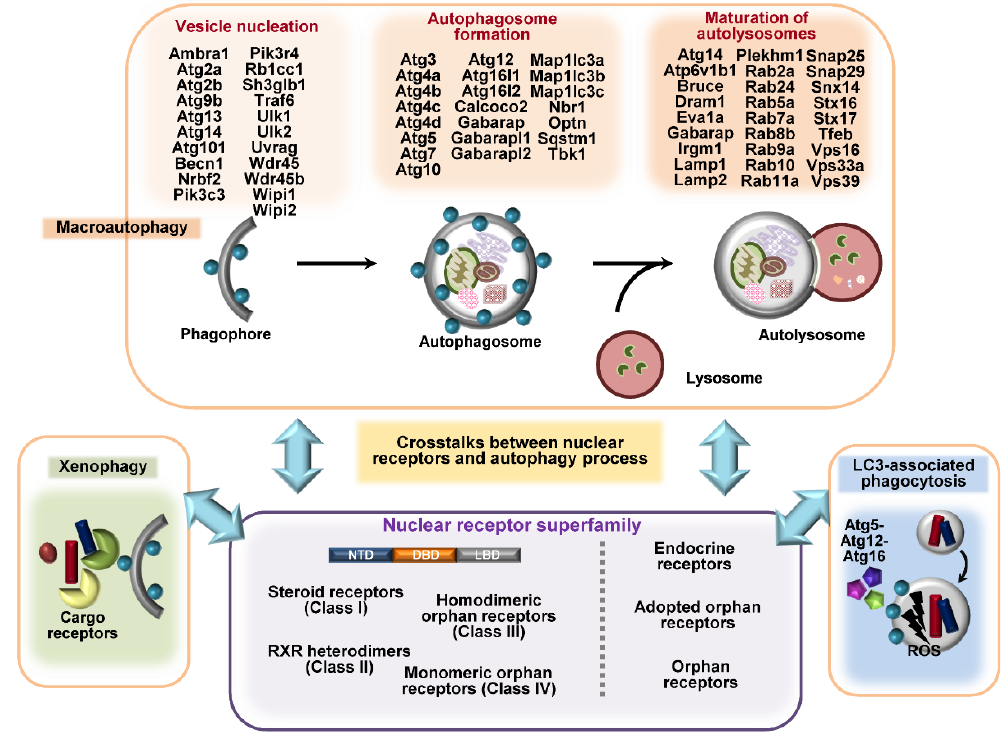
Figure 1. A summarized figure for autophagy genes and different classes of nuclear receptors (NRs). Autophagy processes such as macroautophagy, LC3-associated phagocytosis (LAP), and xenophagy involve different autophagy-related genes (ATGs) or cargo receptors, such as p62, NDP52, and optineurin. The upper panel highlights the different sets of autophagy genes involved in vesicle nucleation, autophagosome formation, and the maturation of autolysosomes. The NR superfamily classes are divided into three or four subclasses according to their structural and functional characteristics and their ligands. NRs are implicated in the regulation of autophagy at transcriptional and post-translational levels. Understanding the mechanisms by which NRs regulate the expression and post-translational modification of ATGs will facilitate the development of novel host-directed antimicrobial agents.